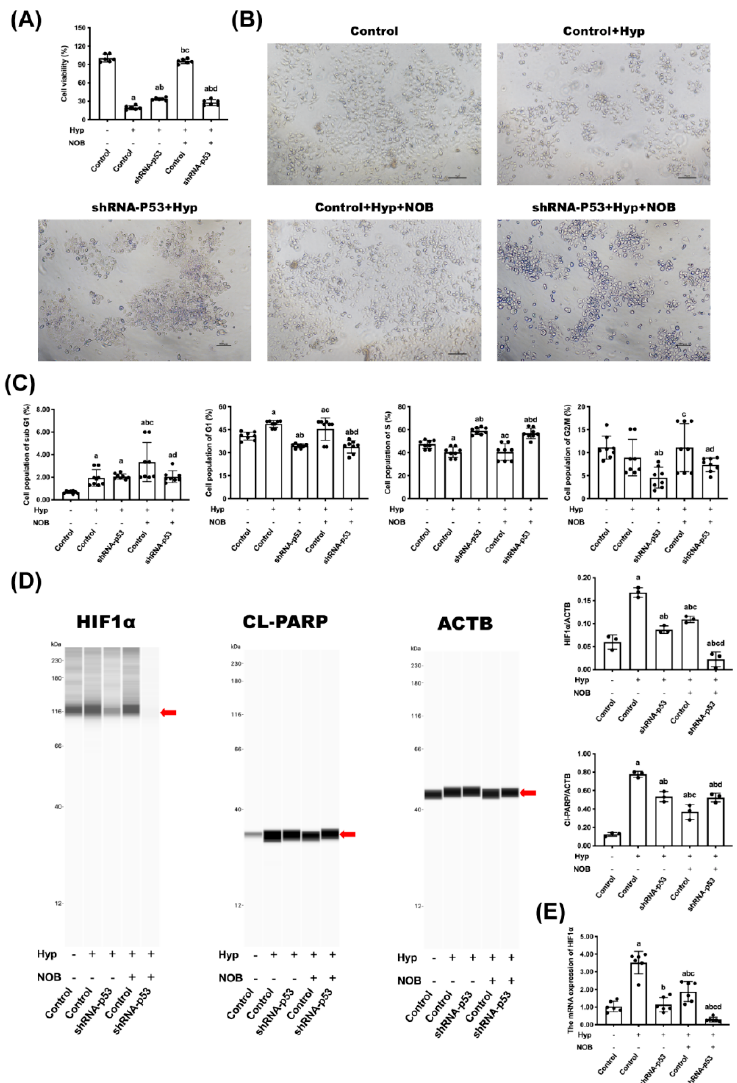
Figure 4. NOB did not change the proliferation and apoptosis of BeWo cell lines after P53 knockdown. ( A ) The cell activity was measured using a CCK-8 assay. ( B ) The morphologies of cells were recorded using a microscope. ( C ) The cell cycle distribution of cells was detected using flow cytometry with PI staining. ( D ) The protein expressions of HIF 1 α and cl-PARP in cell lysate were detected using Wes, and the relative expression levels were quantified. ACTB was used as an internal control, and the relative protein expression was the ratio of the target protein to ACTB. ( E ) The mRNA expressions of HIF 1 α were estimated using an RT-qPCR. ACTB was used as an internal control. Data are expressed as the mean ± standard error (Mean ± SEM). a: comparing with the control groups, p < 0.05; b: comparing with the hypoxia groups, p < 0.05; c: comparing with the hypoxia+shRNA-P53 groups, p < 0.05; d: comparing with the hypoxia+NOB groups, p <